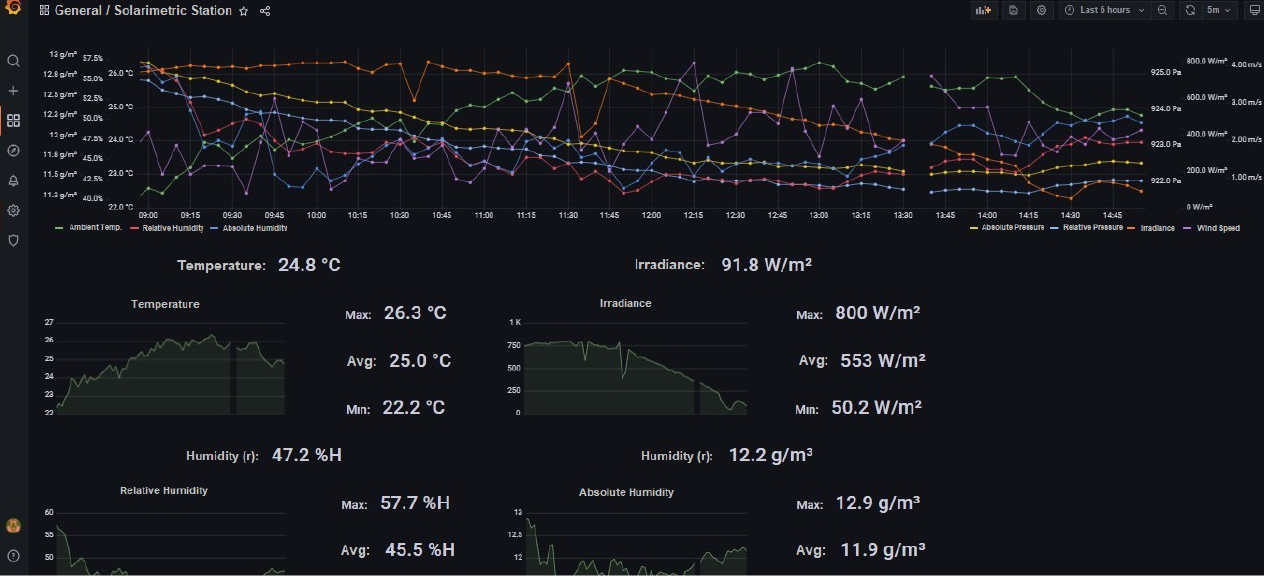
Figure 17. Screen for the measurements of the solar meter